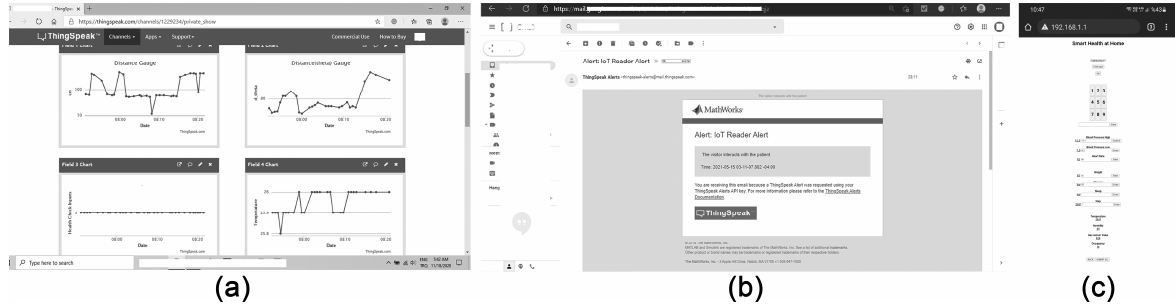
Figure 11. ( a ) The IoT cloud for public monitoring, ( b ) A private alert sent as an electronic mail, ( c ) LAN server of the system.